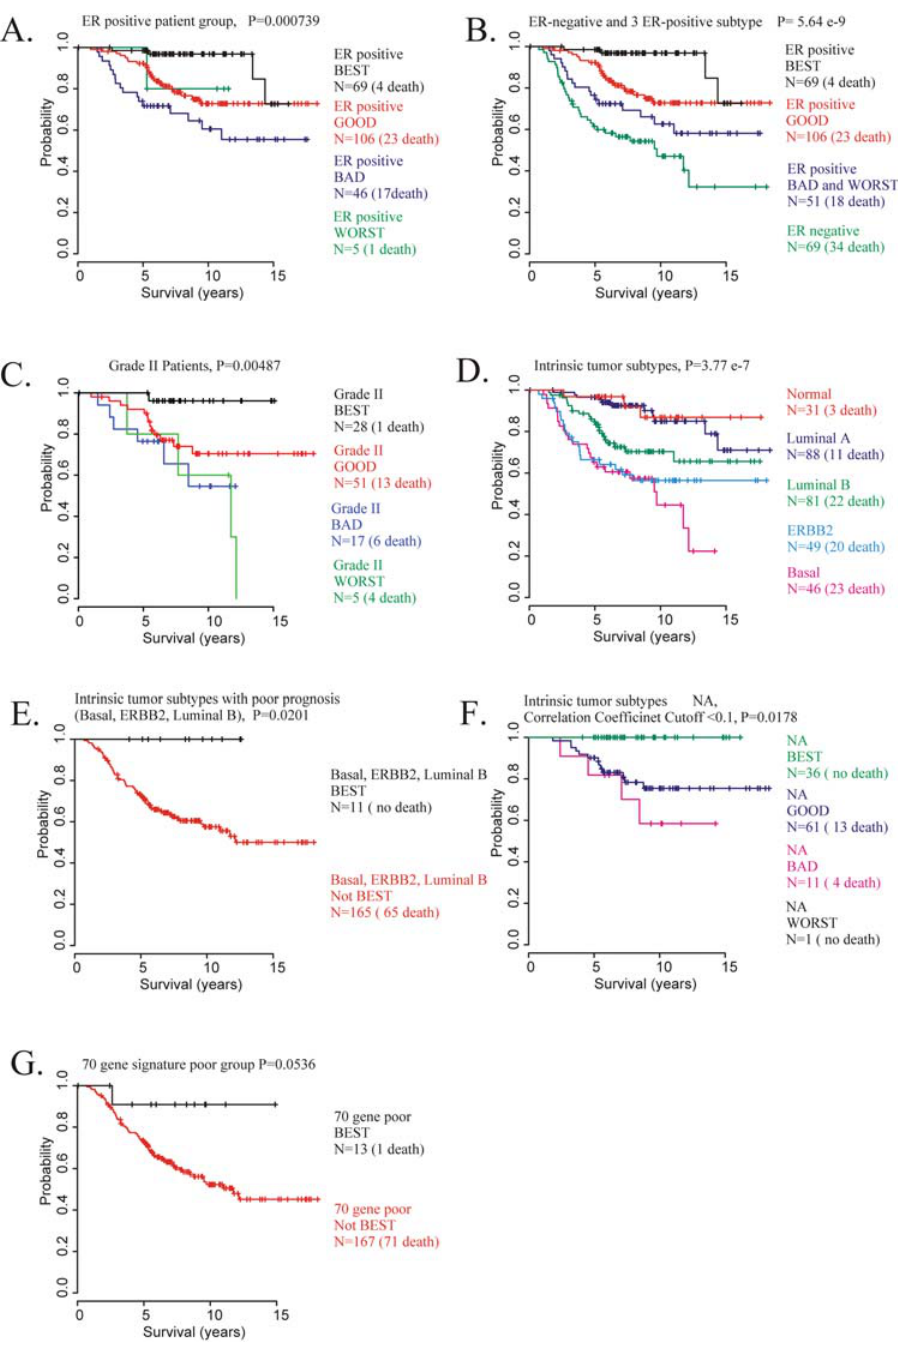
Figure 6. Prediction of breast cancer patients’ outcomes based on a combination of gene expression and other criteria The outcome groups previously assigned in the literature based on various criteria (ER status [5,9], pathological tumor grade [6], intrinsic-sub type [14,17] and 70-gene signature [2,3]) were reassessed and further stratified using our prediction system. A. Kaplan-Meier plot of ER-positive patients stratified by 3 independent prediction steps. Estrogen receptor-positive patients in the NKI data set were further stratified into the BEST prognosis group (69 patients, 4 deaths), GOOD prognosis group (106 patients, 23 deaths), BAD prognosis group (46 patients, 17 deaths) and WORST prognosis groups (5 patients, 1 death). B. Kaplan-Meier plots of survival analysis of ER-negative groups and 3 ER-positive groups that were further stratified by our 3-step prediction analysis. C. Kaplan-Meier plot for patients with grade II tumors after further stratification with 3 independent prediction steps. 28 patients were assigned to the BEST prognosis subtype, showing a 96% 15-year survival rate (27 out of 28 patients). The 5 patients assigned to the WORST prognosis subtype had only a 20% (1 of 5 patients) 15-year survival. D. Kaplan-Meier plot for intrinsic-sub type. Survival analysis of the complete set of NKI samples (295 patients) previously assigned 5 different breast cancer intrinsic-subtypes (Luminal A, Luminal B, ERBB2, Basal, and Normal Breast-like) by nearest centroid class prediction. E. Kaplan-Meier plot for patients with intrinsic-subtypes associated with bad prognosis (Basal, ERBB2 + , and Luminal B) after further stratification with our 3-step prediction analysis. This predictor revealed 11 patients that fell into the BEST prognosis group (no deaths within 15 years). F. Kaplan-Meier plot for the cell types that could not be assigned (NA) based on correlation coefficients cutting threshold of 0.1. Samples previously not assigned (NA) to any of histological cell types were stratified using our prediction system, revealing subgroups with significantly different clinical outcomes. G. Kaplan-Meier plot for the poor prognosis group in the 70-gene-based prediction after further stratification with our 3-step prediction analysis. doi:10.1371/journal.pone.0000145.g006 PLoS ONE |